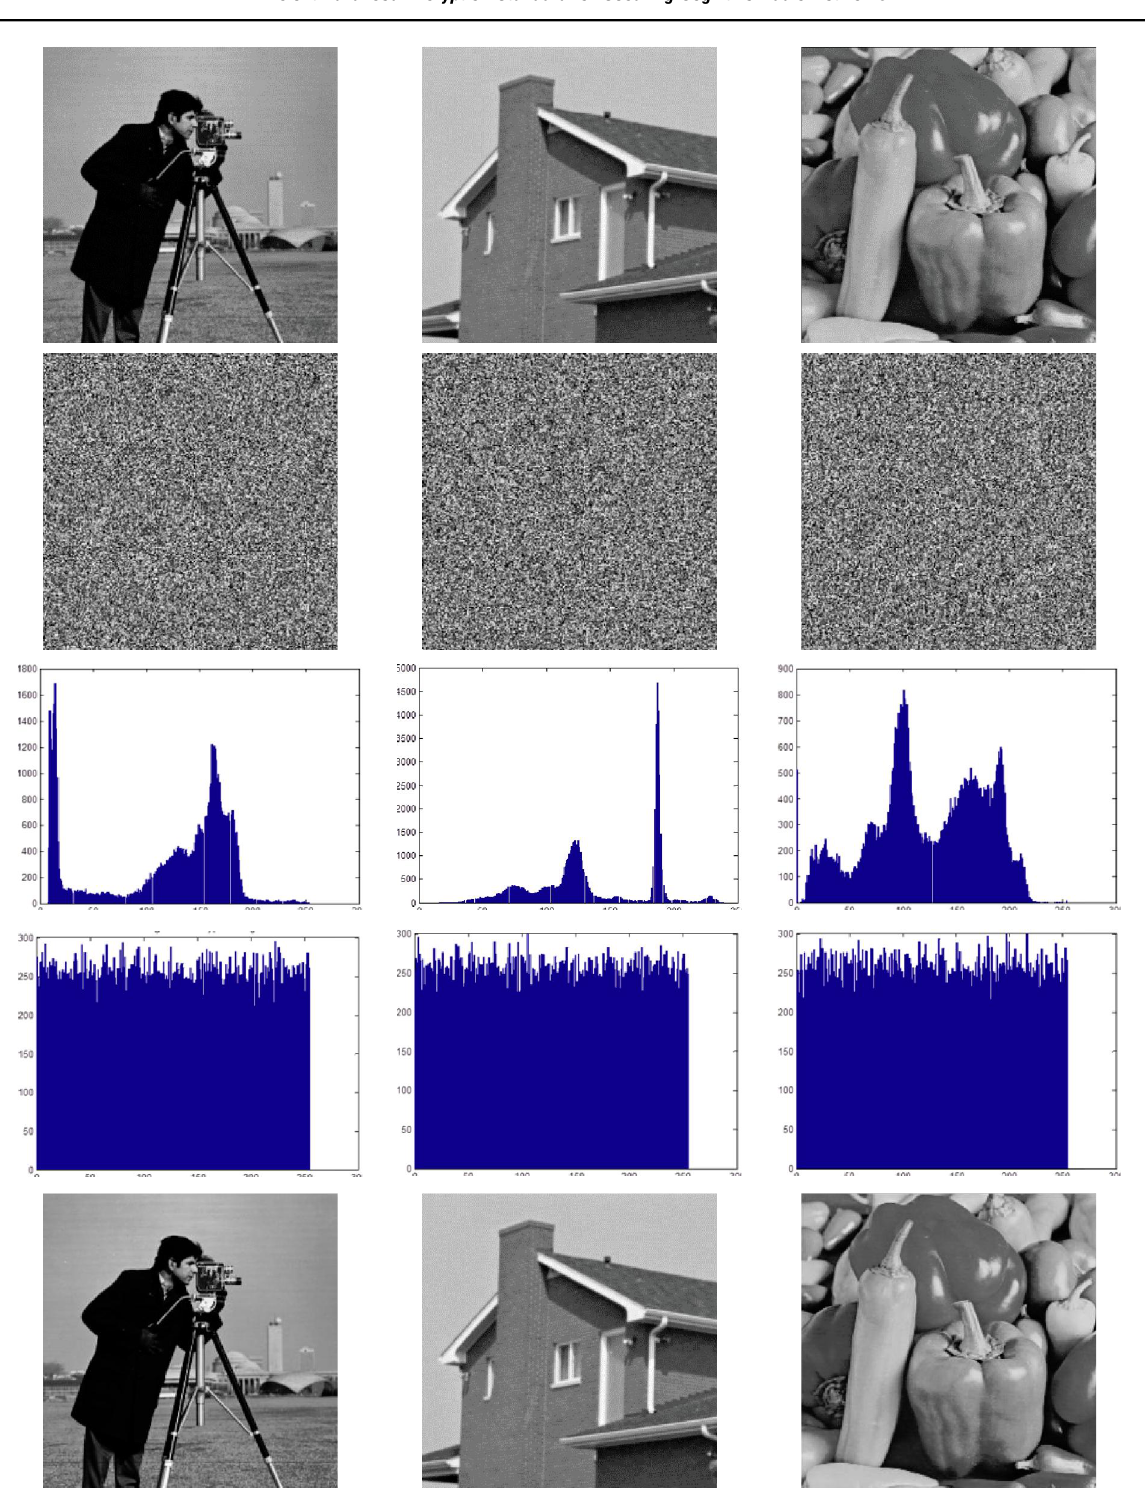
FIG. 4. ROW-1: ORIGINAL IMAGES: (I) BUILDING (II) HOUSE-2 (III) DOLL, ROW-2: ENCRYPTED IMAGES, ROW-3: HISTOGRAMS OF ORIGINAL IMAGES, ROW-4: HISTOGRAMS OF ENCRYPTED IMAGES, ROW-5: DECRYPTED